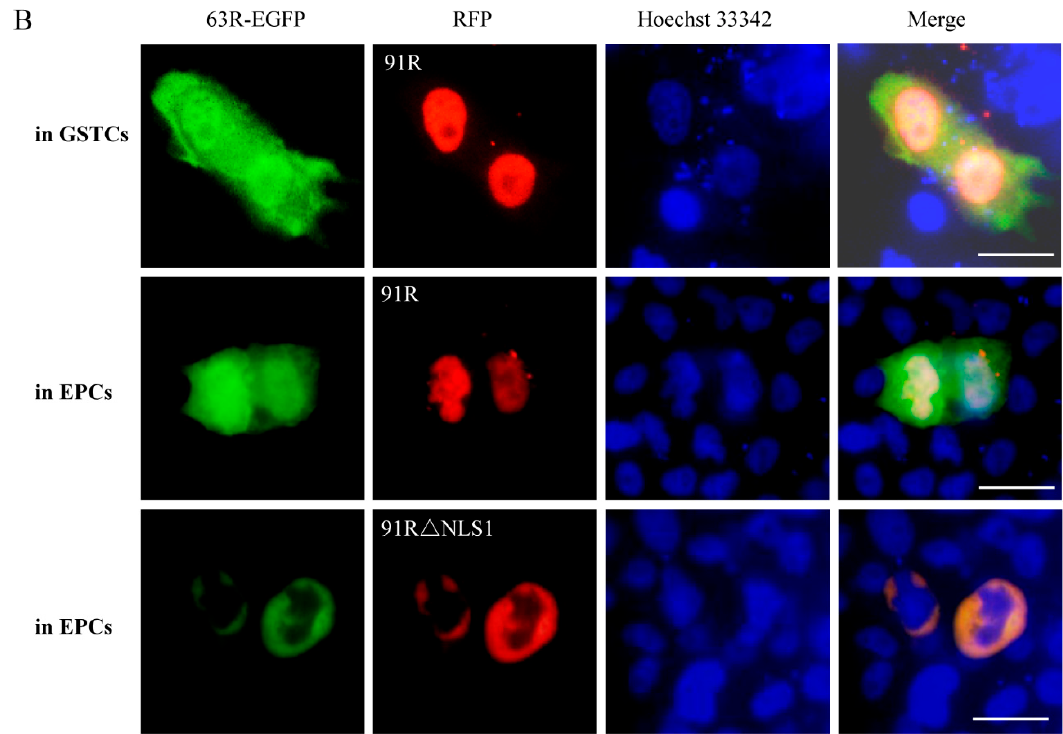
Figure 3. Fluorescence micrographs of cells expressing a single protein or co-expressing two proteins. ( A ) Expressing proteins 63R-EGFP, 91R-RFP, and 91R △ NLS1-RFP alone in giant salamander thymus cells (GSTCs) or Epithelioma papulosum cyprinid cells (EPCs), respectively. ( B ) Co-expressing two proteins, 63R-EGFP + 91R-RFP and 63R-EGFP + 91R △ NLS1-RFP, in GSTCs or EPCs, respectively. 63R-EGFP (green), 91R-RFP (red), 91R △ NLS1-RFP (red), nucleus (blue), and colocalization ( yellow ). Scale bar: 10 μ m.